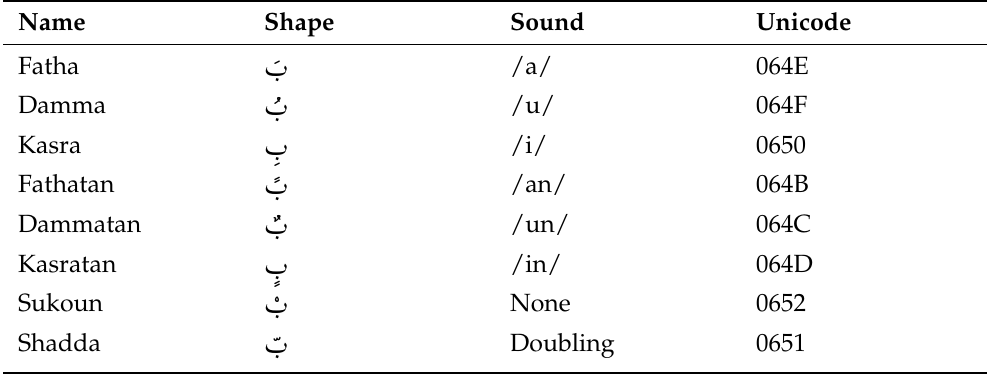
Table 1. Primary Arabic